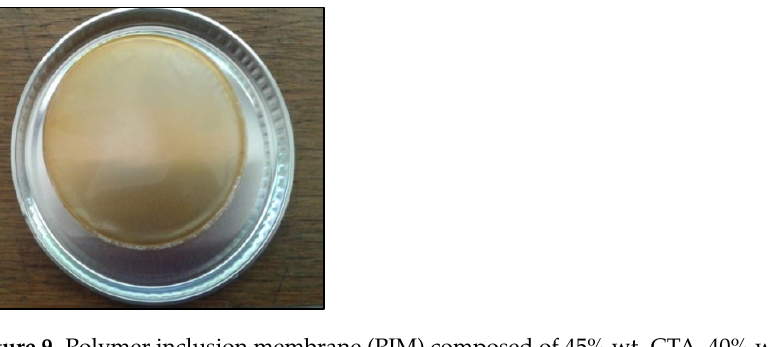
Figure 9. Polymer inclusion membrane (PIM) composed of 45% wt. CTA, 40% wt. di(2-ethylhexyl) phosphoric acid and 15% wt. acetylated lignin. Adapted from